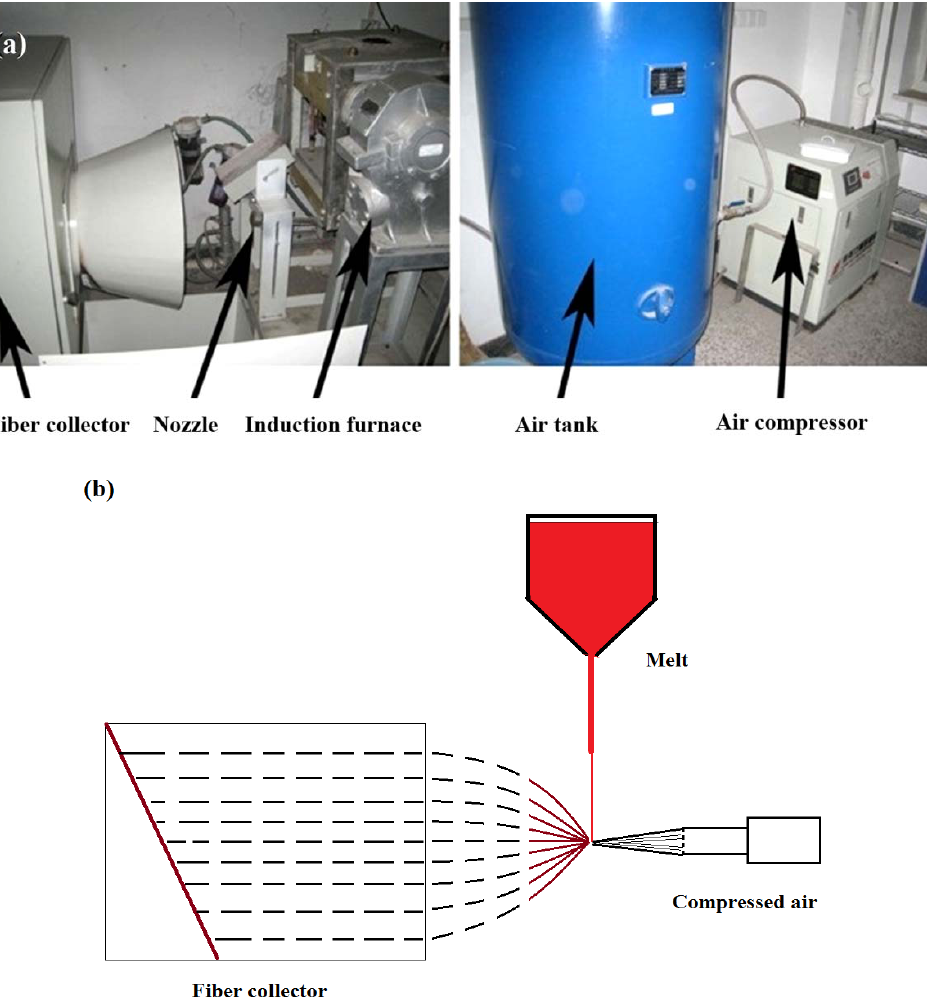
Figure 2. ( a ) Experimental setup ( b ) Schematic diagram of producing slag fiber with air injection